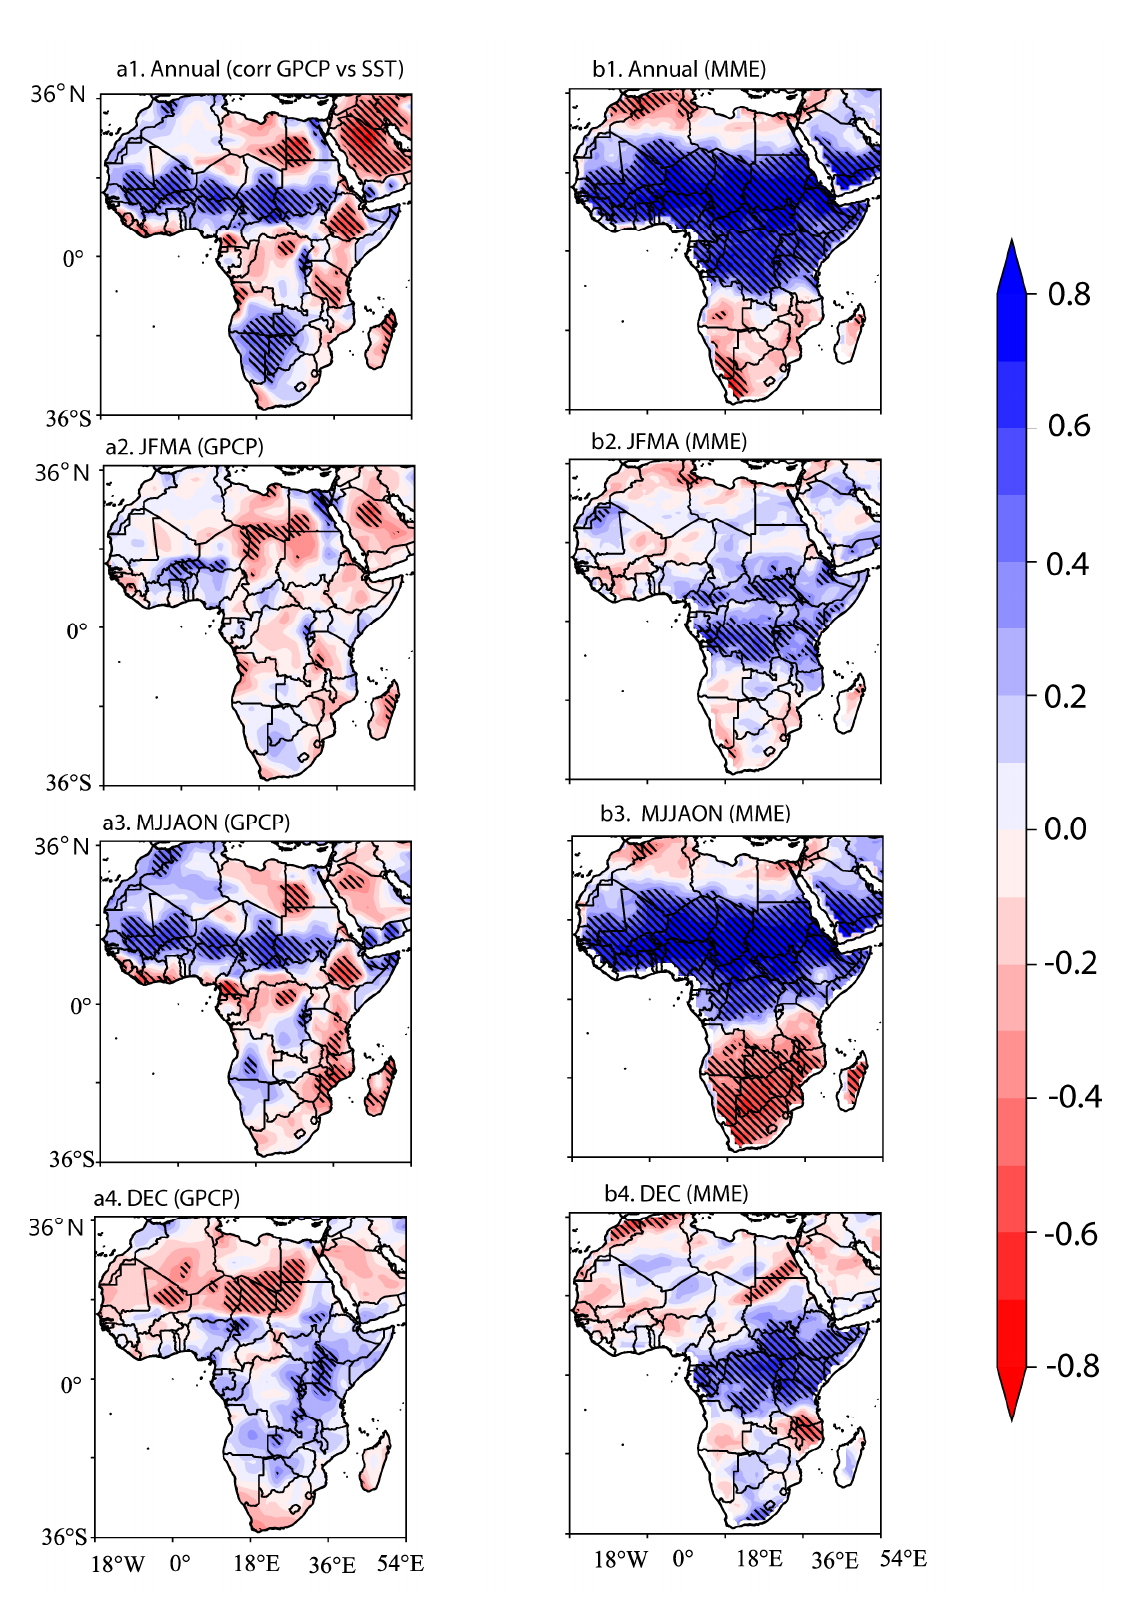
Figure 10. Spatial distributions of correlation coefficients of GPCP and CMIP6 MME PREC and SST (i.e., annual scale ( a1 , b1 ), JFMA ( a2 , b2 ), MJJASON ( a3 , b3 ), and December ( a4 , b4 )). during 1980–2014. Hatched area indicates a 95% confidence level.